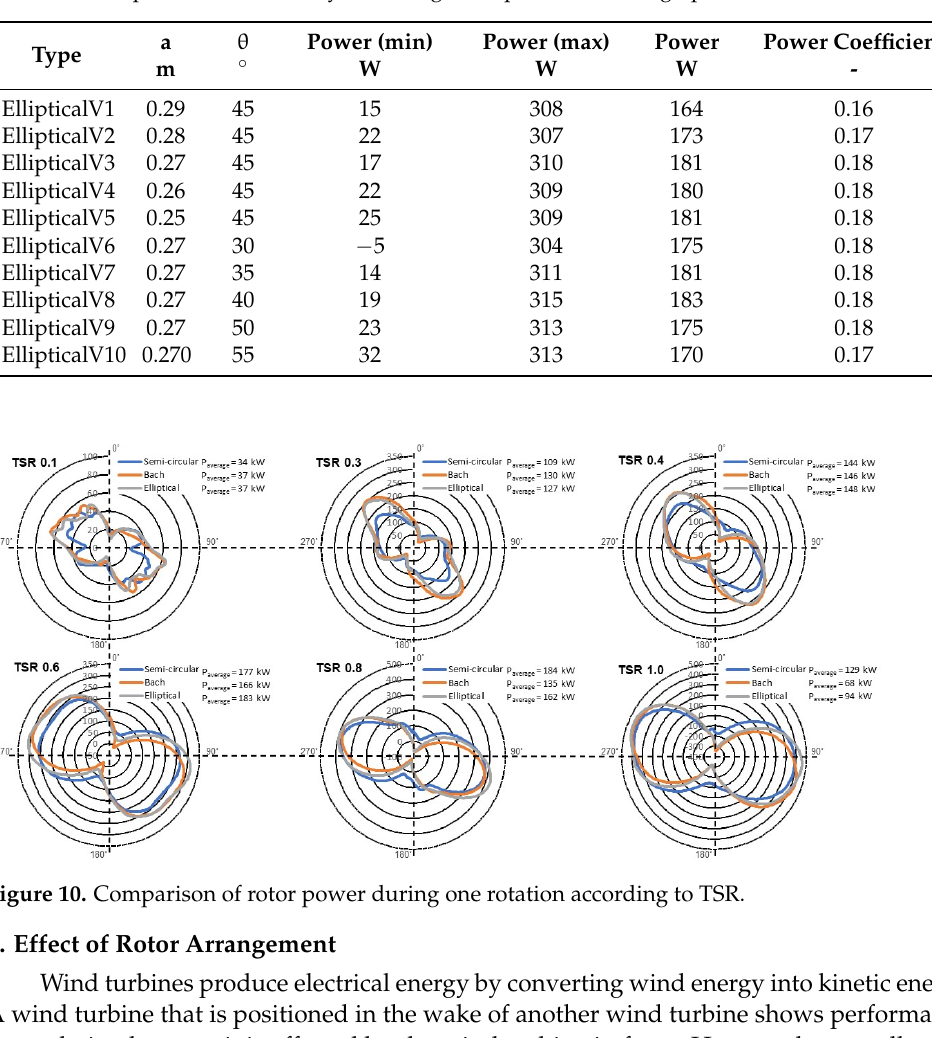
Table 4. Rotor power and efficiency according to elliptical rotor design parameters.